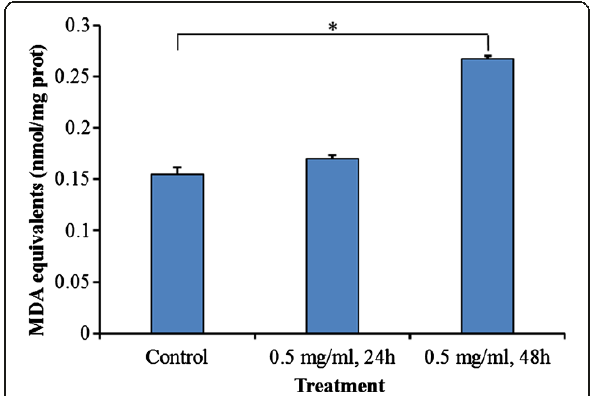
Figure 1 Pro-oxidant activity of crude aqueous extract of P. indica root in HeLa cancer cells. Measurement of thiobarbituric acid reactive species (TBARS) during malondialdehyde peroxidation in HeLa cells treated with 0.5 mg/ml of crude aqueous extracts at 24-hr and 48-hr incubation respectively were performed as described in Methods. Each experiment was done in triplicate. The pro-oxidant activity of the crude aqueous extract of P. indica root was evident. Data are expressed as mean ± SD. * P <